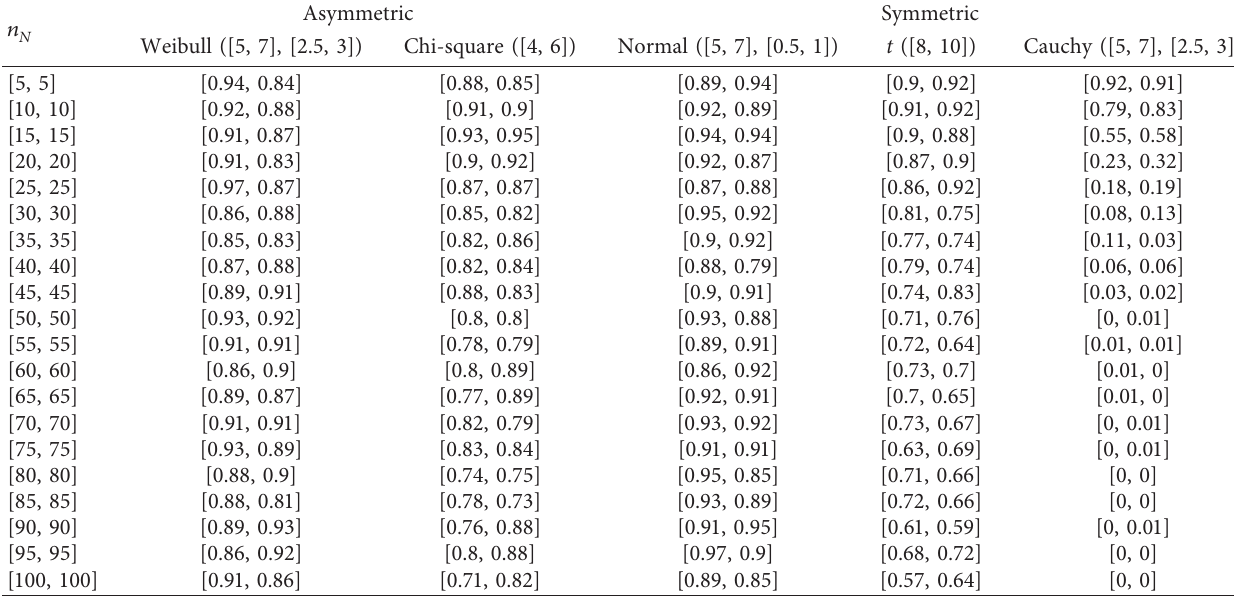
Table 3: Error rate for the proposed test.